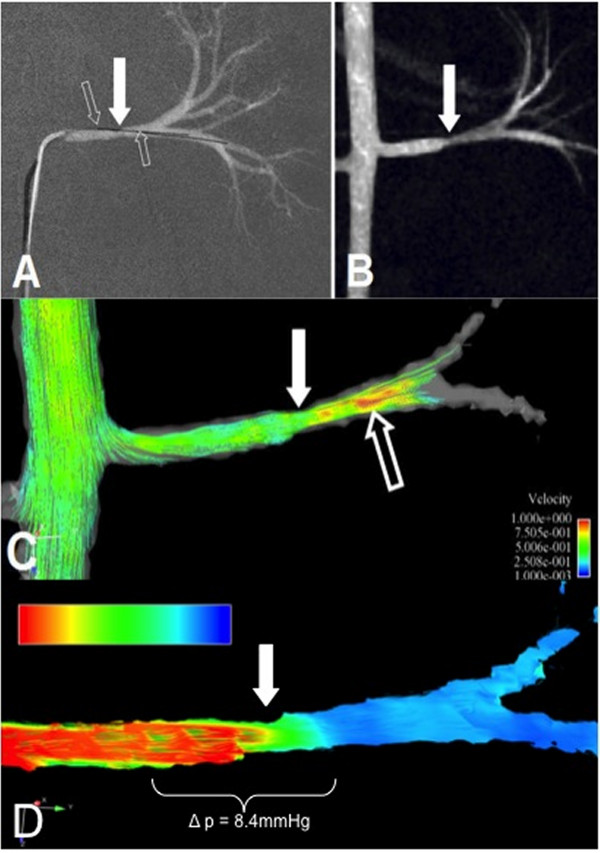
Based on conventional phase-contrast MRA and driven by the increase in available post-processing computing power, a new vascular imaging technique with great clinical potential has evolved in the past few years: a flow-sensitive, 3-dimensional, and 3-directional time-resolved gradient echo sequence--often referred to as 7D-MRA. This figure illustrates the evaluation of renal artery stenosis using DSA for reference (A) and MRA (B). The flow alterations around the stenosis present can not only be visualized on color coded post-processed 7D-MRA parameter maps (C) with red indicating increased post stenotic flow, but also the trans-stenotic pressure gradient can also be quantified (D) using the Bernoulli equation. Courtesy of PD Dr. Bley, UKE Hamburg.